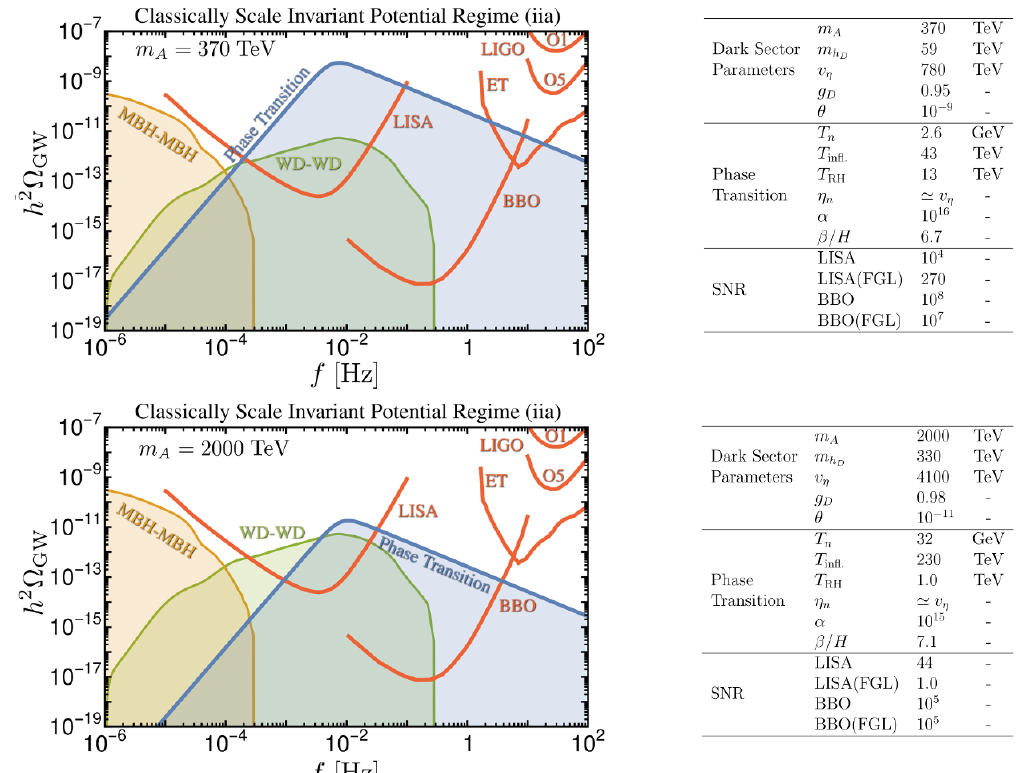
Figure 11 . Examples of GW spectra in regime (iia). Although (cid:11) (cid:29) 1, and (cid:12)=H is similar for both phase transitions, the period of matter domination after the PT is longer for larger m A , leading to a suppressed signal. For purposes of illustration we also include the unresolvable foreground from black hole binaries with masses 10 2 M (cid:12) (cid:0) 10 10 M (cid:12) (MBH-MBH)